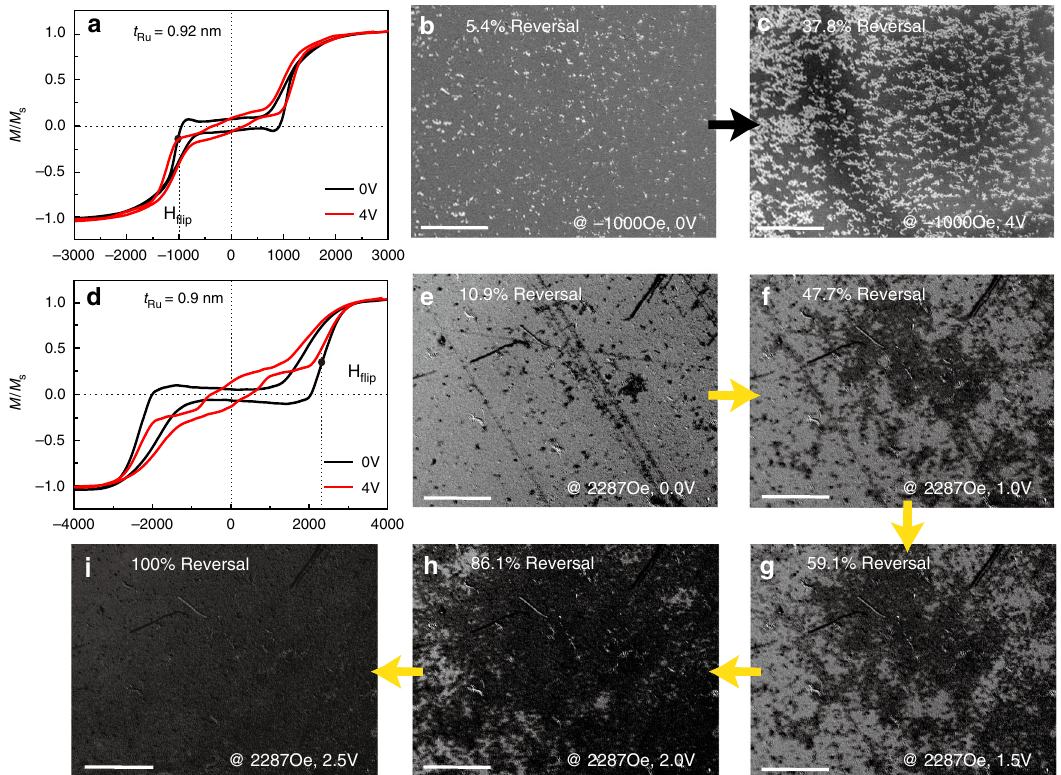
Fig. 5 Voltage control domain switching evidenced by (Pt/Co) 2 /Ru/(Co/Pt) 2 /glass SAF heterostructures. a Ex situ VSM hysteresis loops at t Ru = 0.92nm. b , c are corresponding domain nucleations at 0 and 4 V. The voltage dwell time is 5 min. d Ex situ VSM hysteresis loops at t Ru = 0.9 nm. e – i are the corresponding domain switching images at various V g . The determination of reversal ratio: count the ratio of light ( b , c ) and shade ( e – i ) at fi rst, and then normalized by the value of saturated